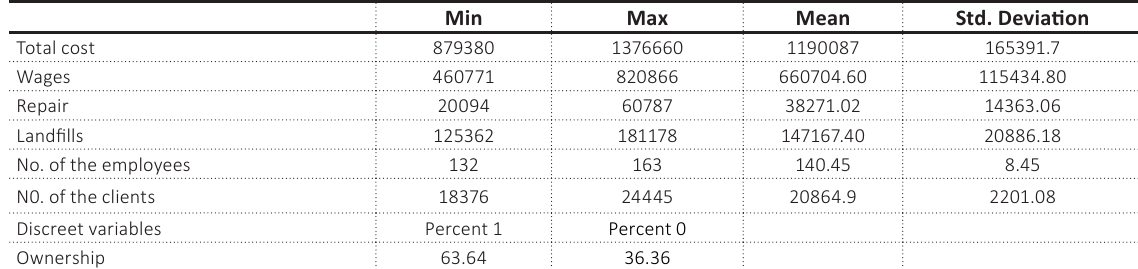
Table 3. Descriptive data